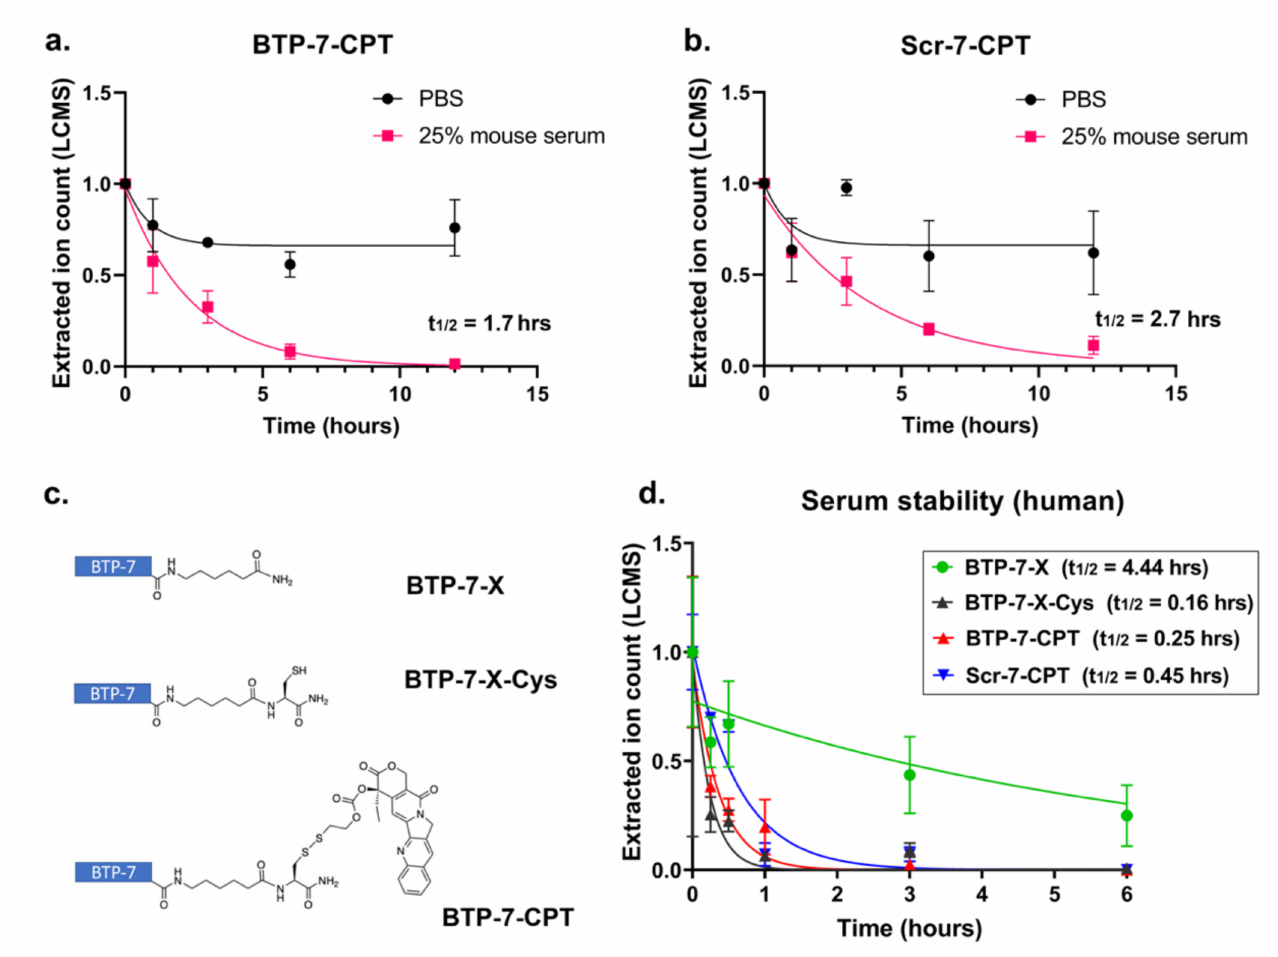
Figure 5. Stability of peptide–drug conjugates in serum. ( a , b ) LC-MS analysis showing the level